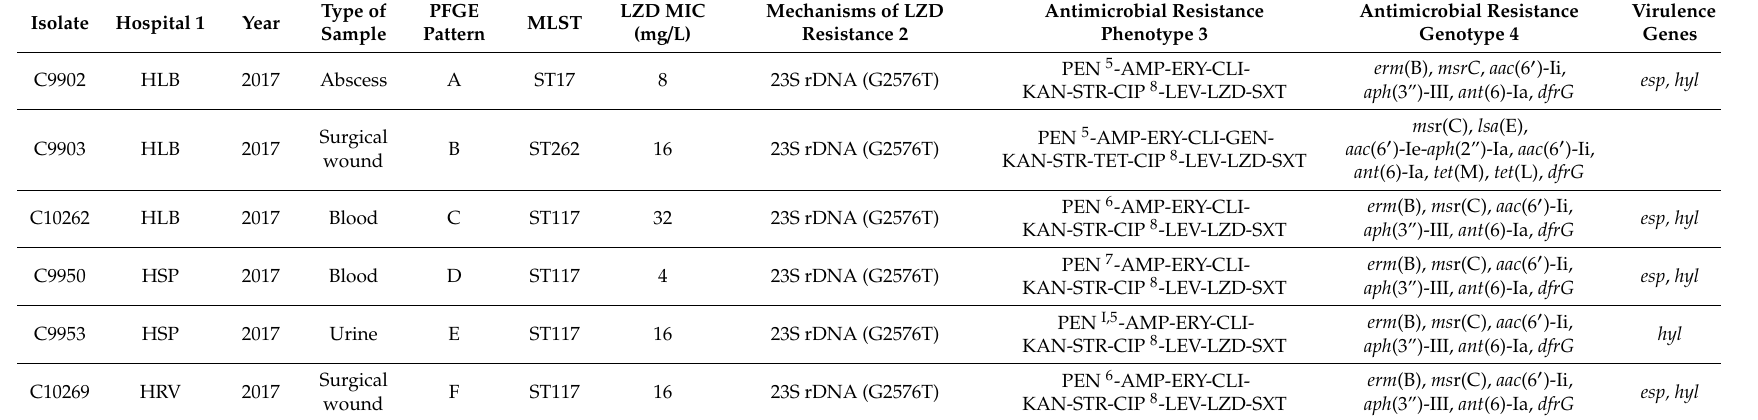
Table 2. Characterization of the six clinical linezolid-resistant E. faecium isolates investigated in this